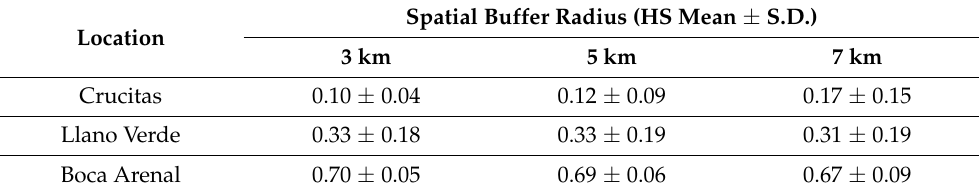
Figure 9. Ensemble distribution model for Anopheles albimanus in ( A ) Cutris and Pocosol districts, where symbols indicate the locations associated with the 2018–2019 Crucitas malaria outbreak (for details, refer to the inset legend), and in ( B ) Crucitas, ( C ) Llano Verde and ( D ) Boca Arenal. In all panels, color indicates habitat suitability quantified by probabilities from 0 to 1, as presented in the legend of panel ( A ). In all panels, the Y axis is the latitude and the X axis is the longitude. In all panels, each pixel is a 250 m square, and in panels B, C and D, the circular areas have a 7 km radius. Table 3. Anopheles albimanus mean habitat suitability (HS) probability around the three locations of the 2018–2019 malaria outbreak associated with illegal open-pit gold mining in Crucitas, Costa